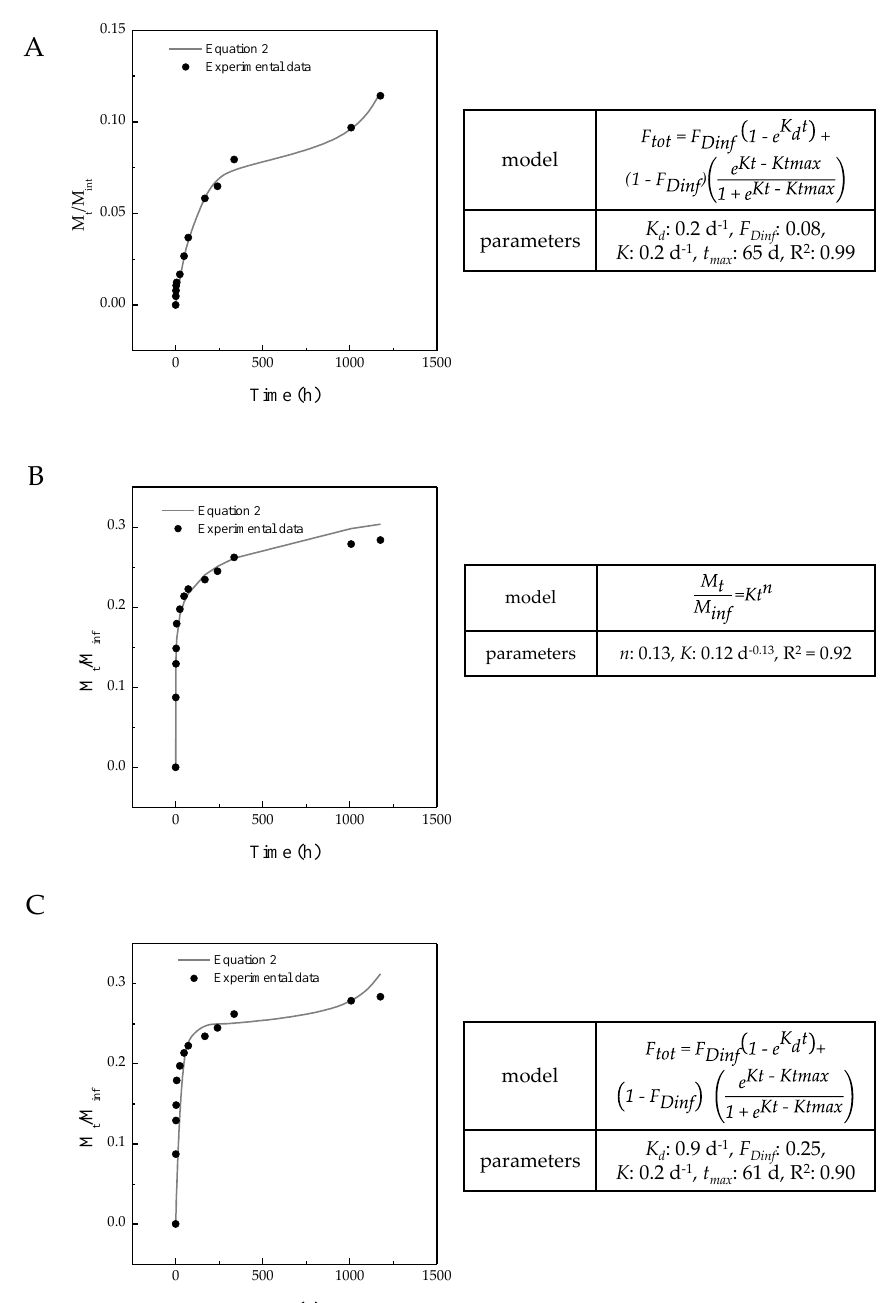
Figure 7. In vitro release profile fitting with the mathematical models from ( A ) PLGA, ( B ) PCL, and ( C ) PLA MPs. PLGA: poly(lactic- co -glycolic acid), PCL: poly( ε -caprolactone), PLA: poly(lactic acid).